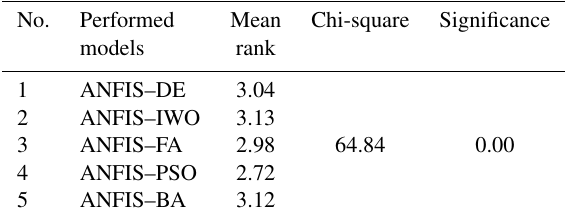
Table 3. Results of Friedman test.